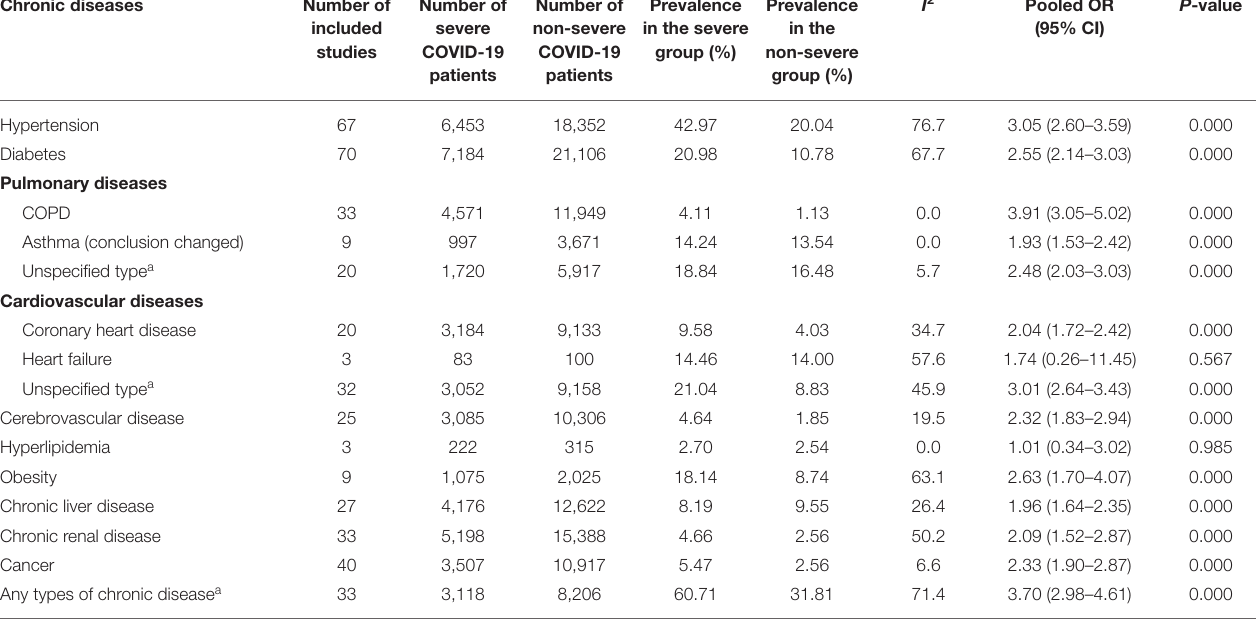
TABLE 2 | Associations between chronic diseases and severity of COVID-19. Chronic diseases Number of